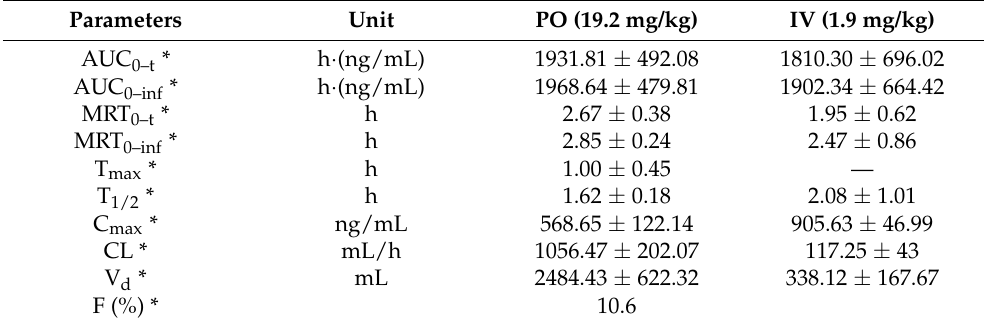
Figure 2. Mean blood concentration vs. time profiles of 1 −(3′− bromophenyl) − heliamine after administration to SD rats ( n = 6), (A) 19.2 mg/kg, orally; (B) 1.9 mg/kg, intravenously. Table 1. The main pharmacokinetic parameters of 1 − ( 3′− bromophenyl) − heliamine in rats after intravenous and oral administration ( n = 6, mean ± SD).